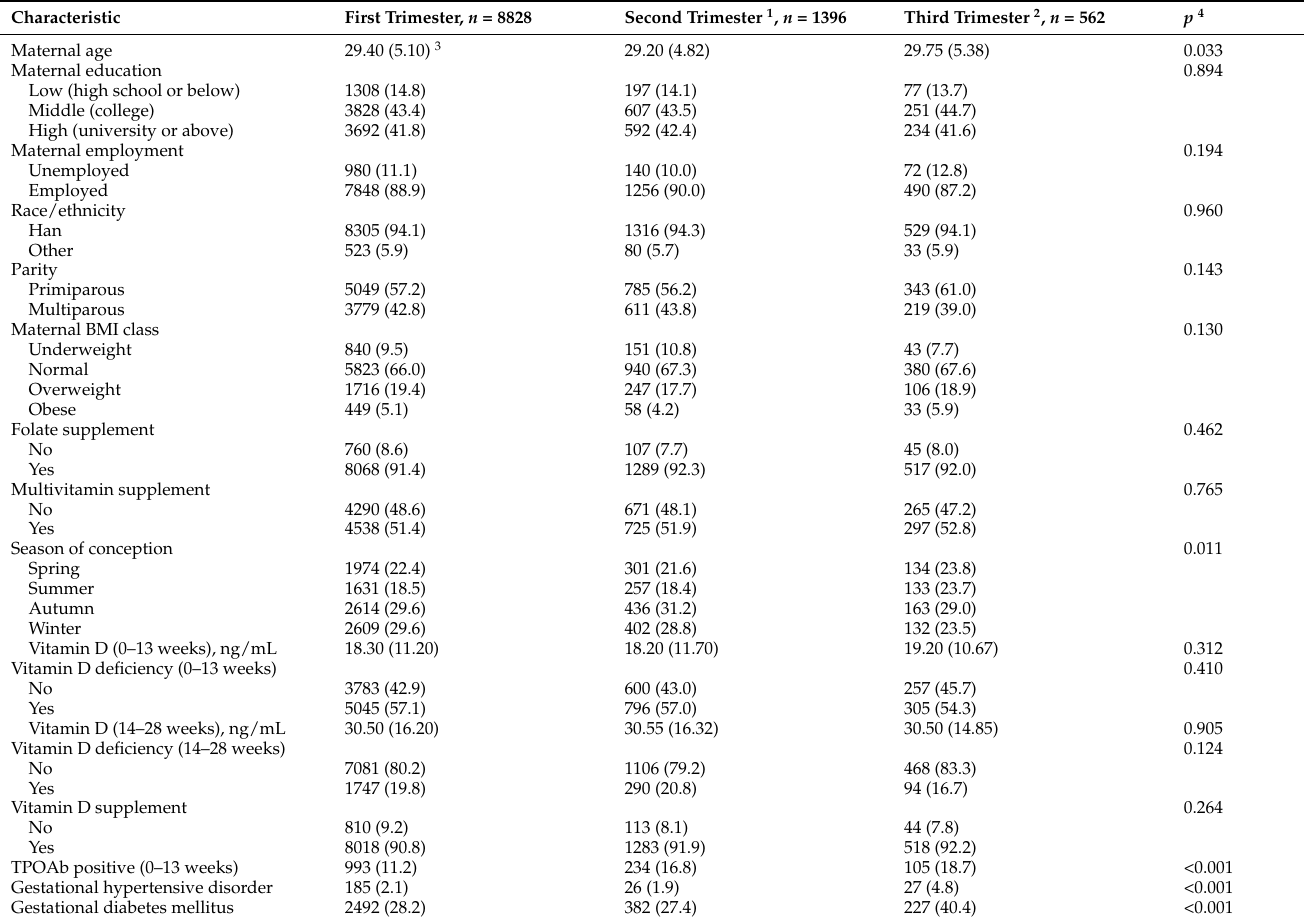
Table 1. Characteristics of participants in three different